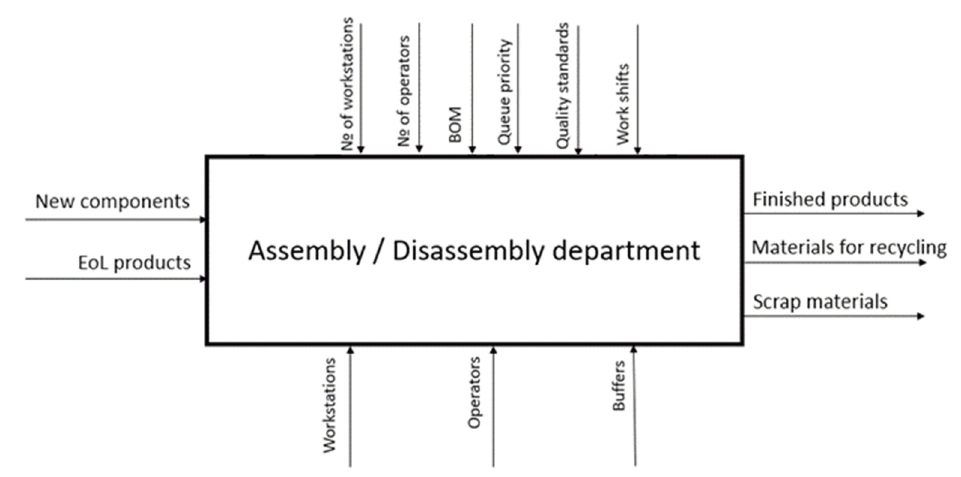
Figure 1. Model IDEF0 scheme (Sergio et al.,